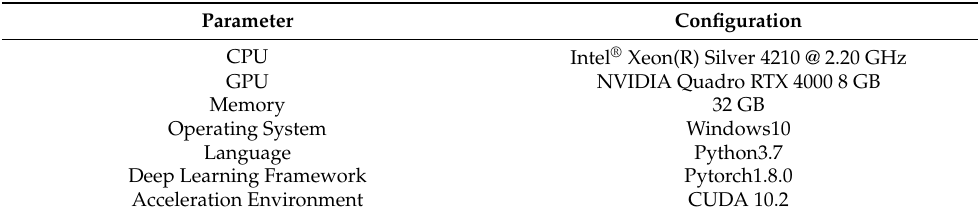
Table 1. Experimental environment.